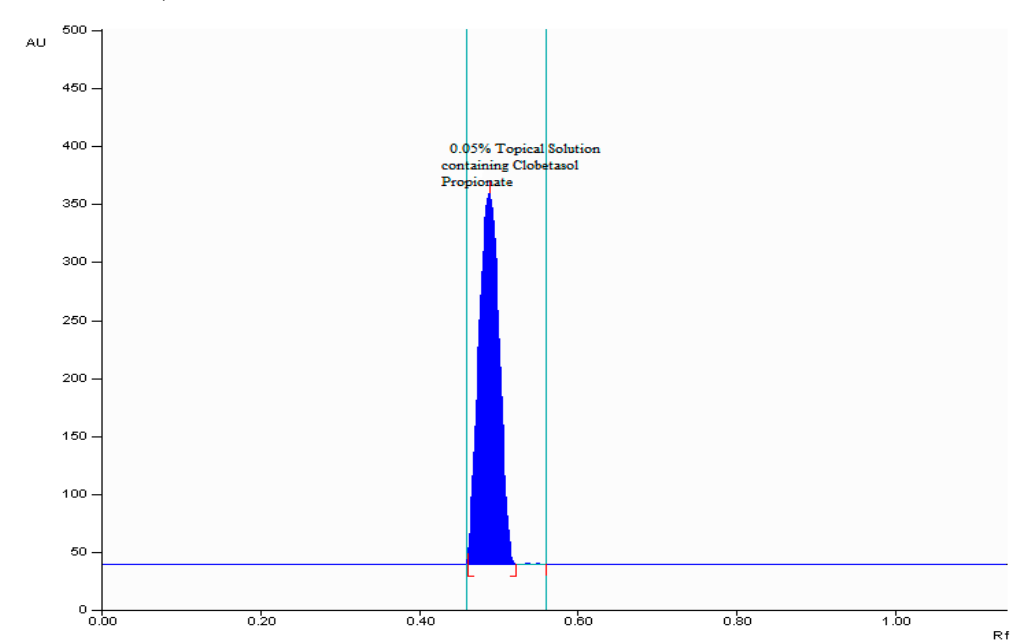
Figure 4. TLC chromatogram of marketed formulation (0.05% topical solution) of clobetasol propionate.